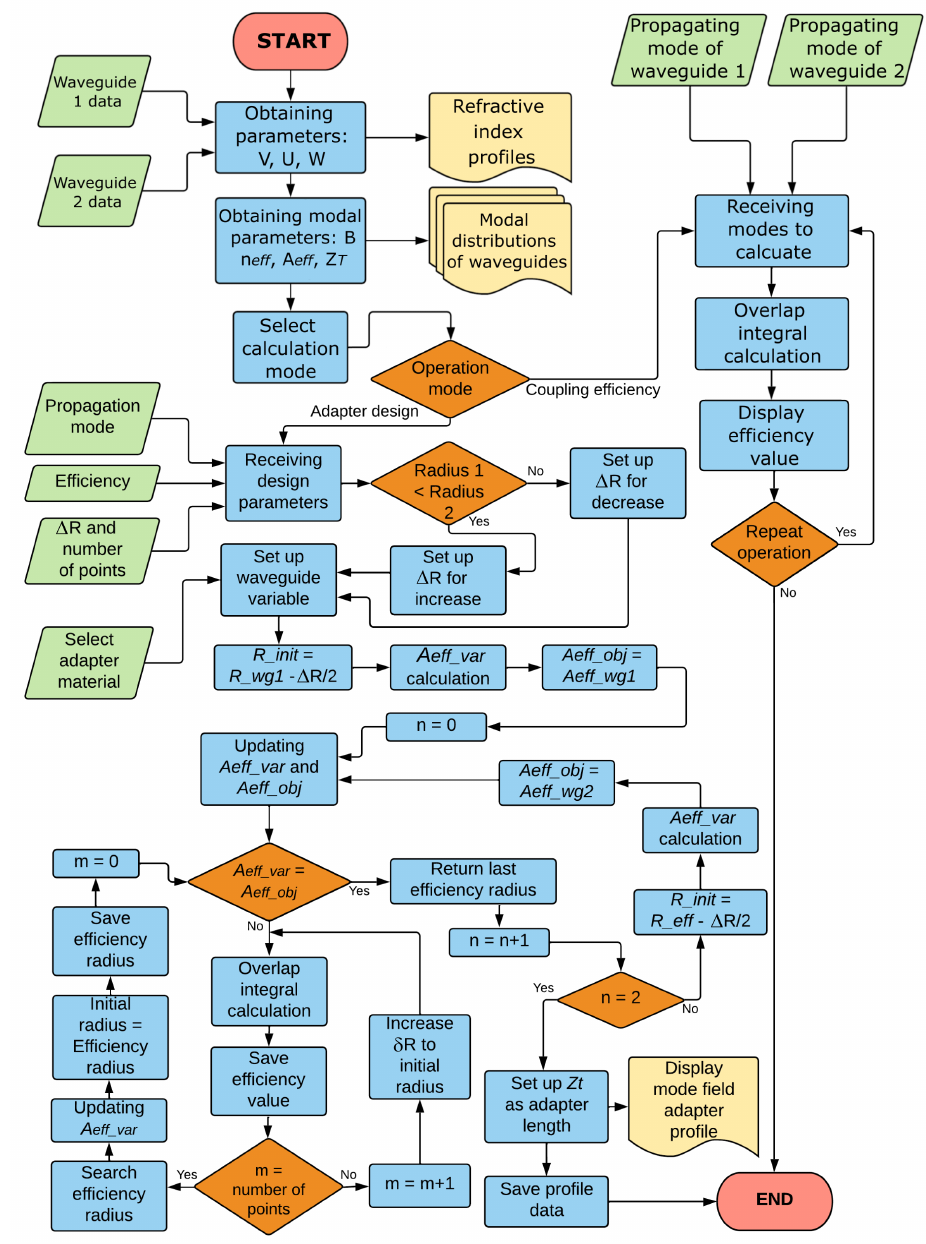
Figure 2. Flowchart of the algorithm to obtain an MFA optimized for a specific mode between two different optical